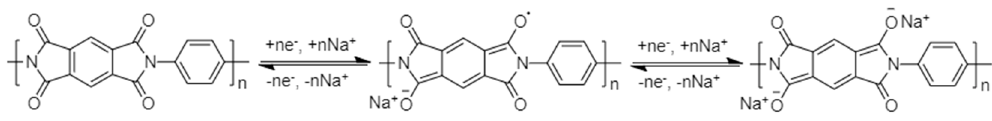
Figure 1. The structure of typical polyimides suitable for use in NIBs.